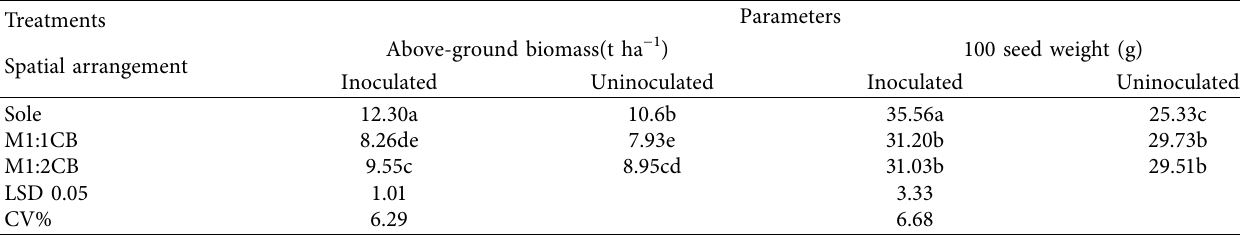
Table 10: Te interaction efects of spatial arrangement and inoculation on above-ground biomass and hundred seed weight of common bean.